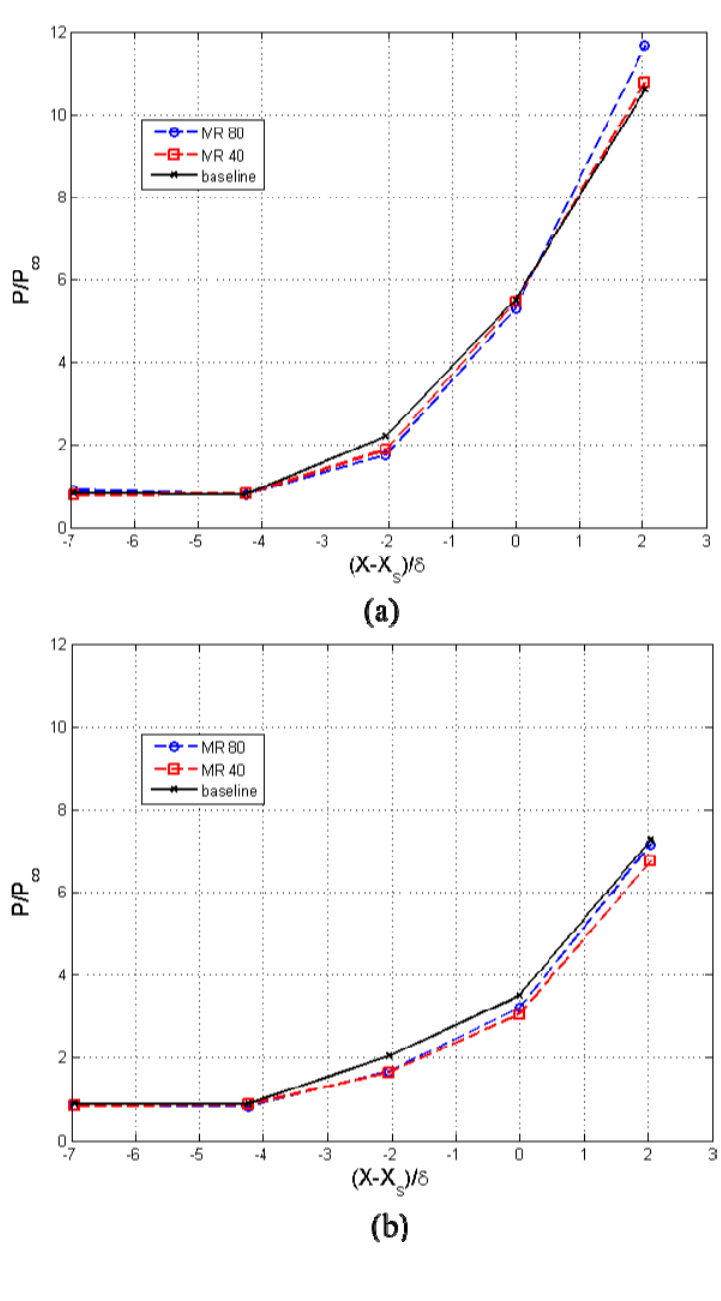
Figure 16. Streamwise surface pressure measurements at centerline ( a ) and z = 20 mm ( b ) with shock incident at 14.2 δ downstream the mid-chord of MR40 and